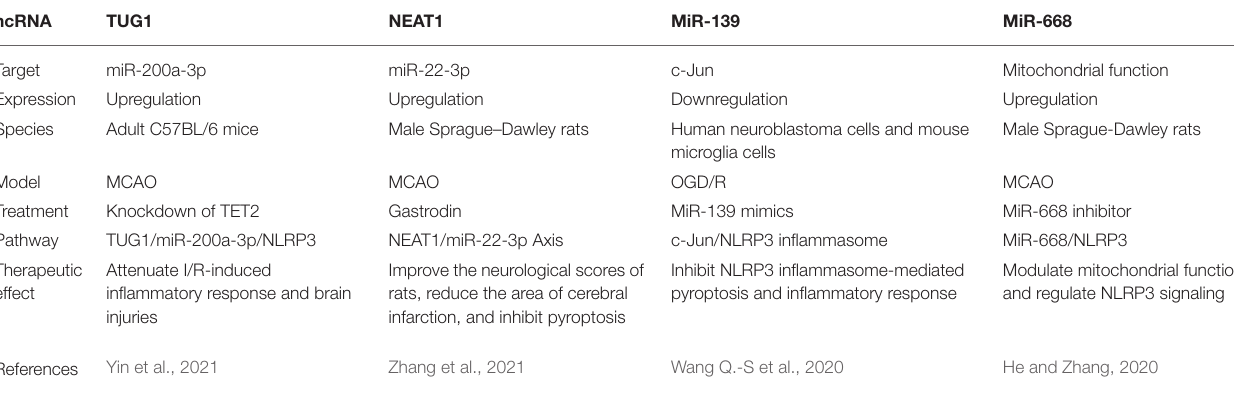
TABLE 3 | Selected noncoding RNAs involving NLRP3 inflammasome in cerebral I/R